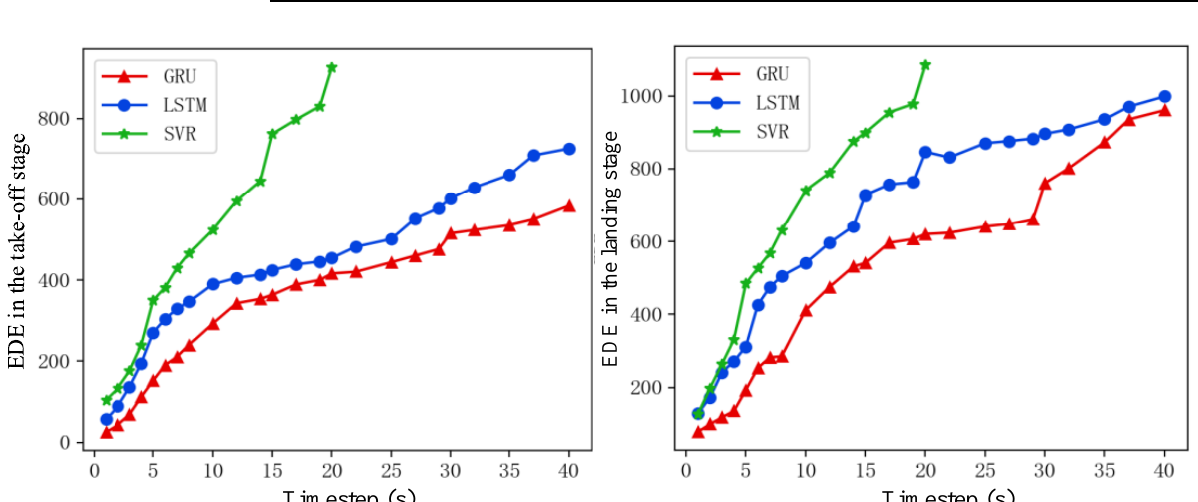
Figure 2. Performance comparison for three models.